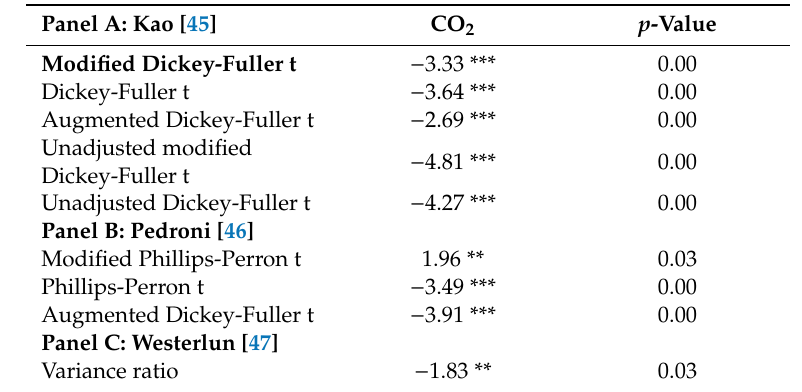
Table 5. Cointegration